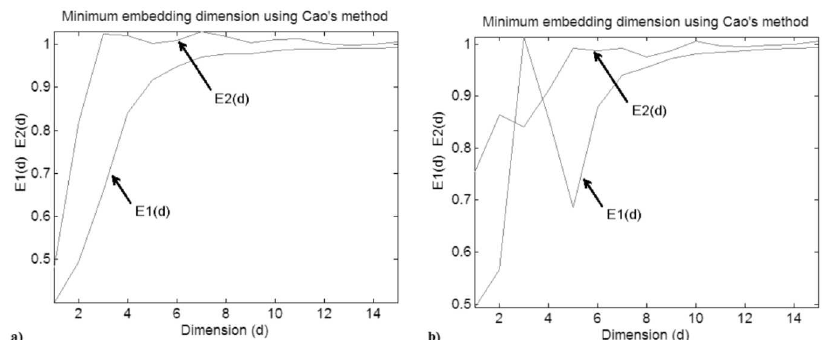
Figure 5. Minimum embedding dimension using Cao’s method for the EHG signal: a) the raw, b) the differentiated